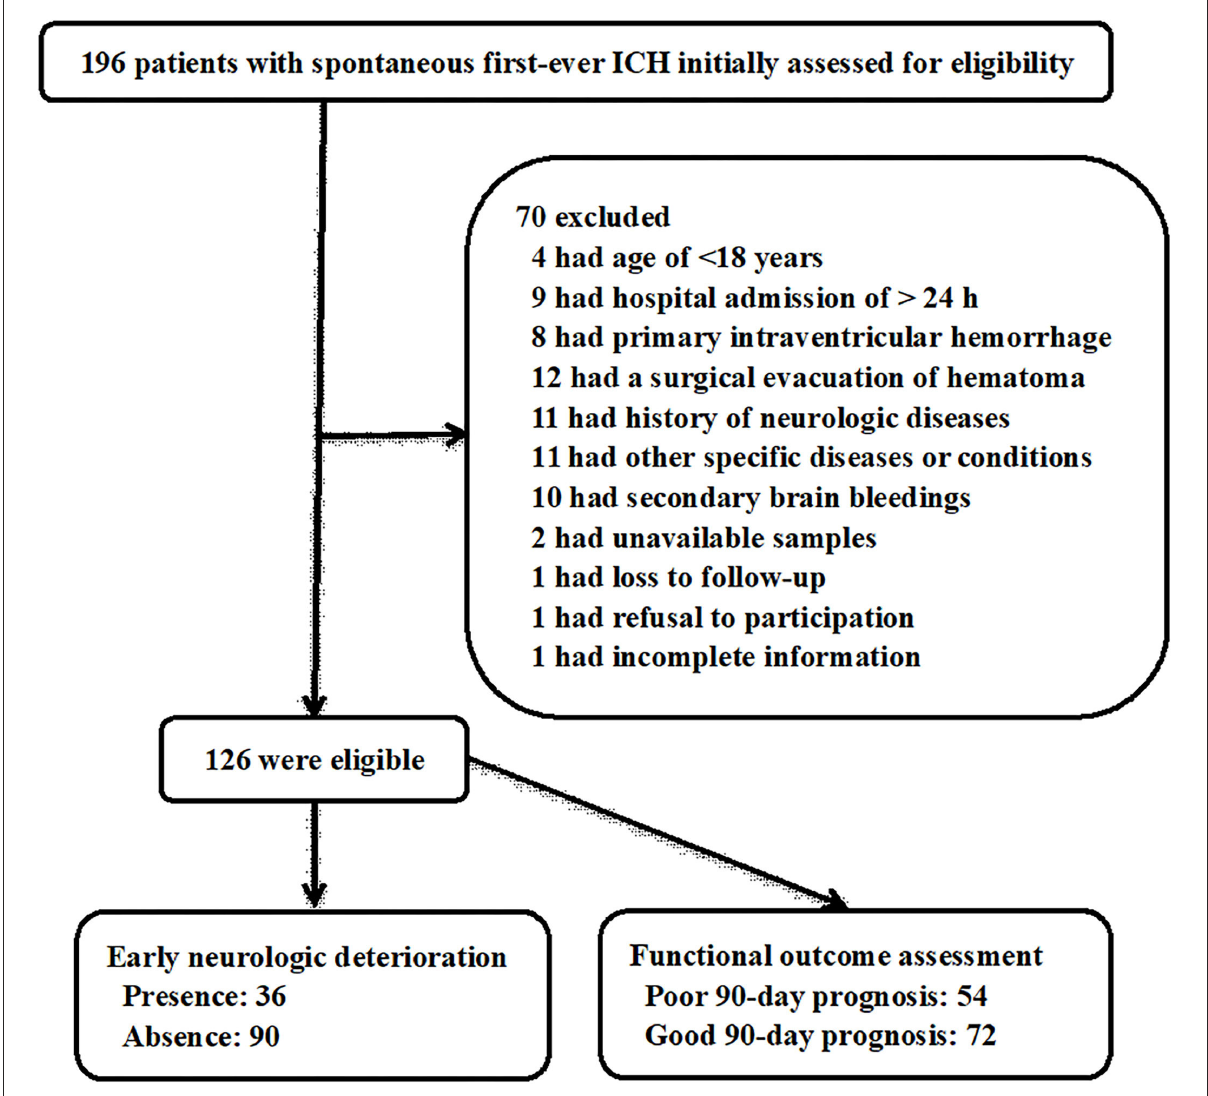
FIGURE1 Flowchart for selecting eligible patients with spontaneous intracerebral hemorrhage. A total of 196 intracerebral hemorrhage patients were first screened and then 70 of them were excluded from this study. Finally, a total of 126 patients were eligible for further analysis, among whom, there were 36 patients with early neurological deterioration and 54 with poor prognosis at 90 days after stroke. ICH, intracerebral